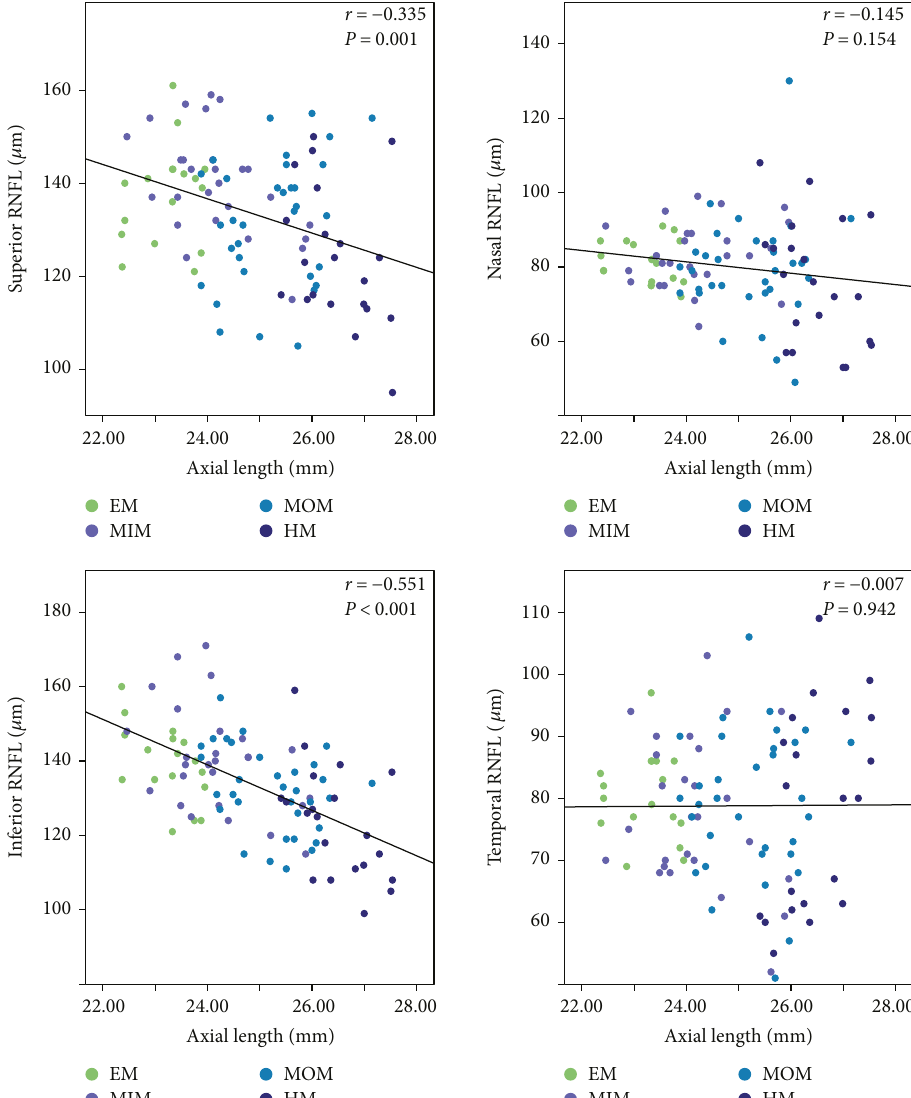
Figure 2: Scatterplots illustrating the linear (black line) associations between axial length (mm) and OCTA peripapillary quadrant (superior, nasal, inferior, and temporal) RNFL thickness ( μ m) measurement of the studied eyes. r , correlation coe ffi cient from the Spearman rank correlation analysis; EM, emmetropia, MSE 0.50D to − 0.50 D; MIM, mild myopia, MSE − 0.75D to − 2.75D; MOM, moderate myopia, MSE − 3.00D to − 5.75D; HM, high myopia, MSE ≤−